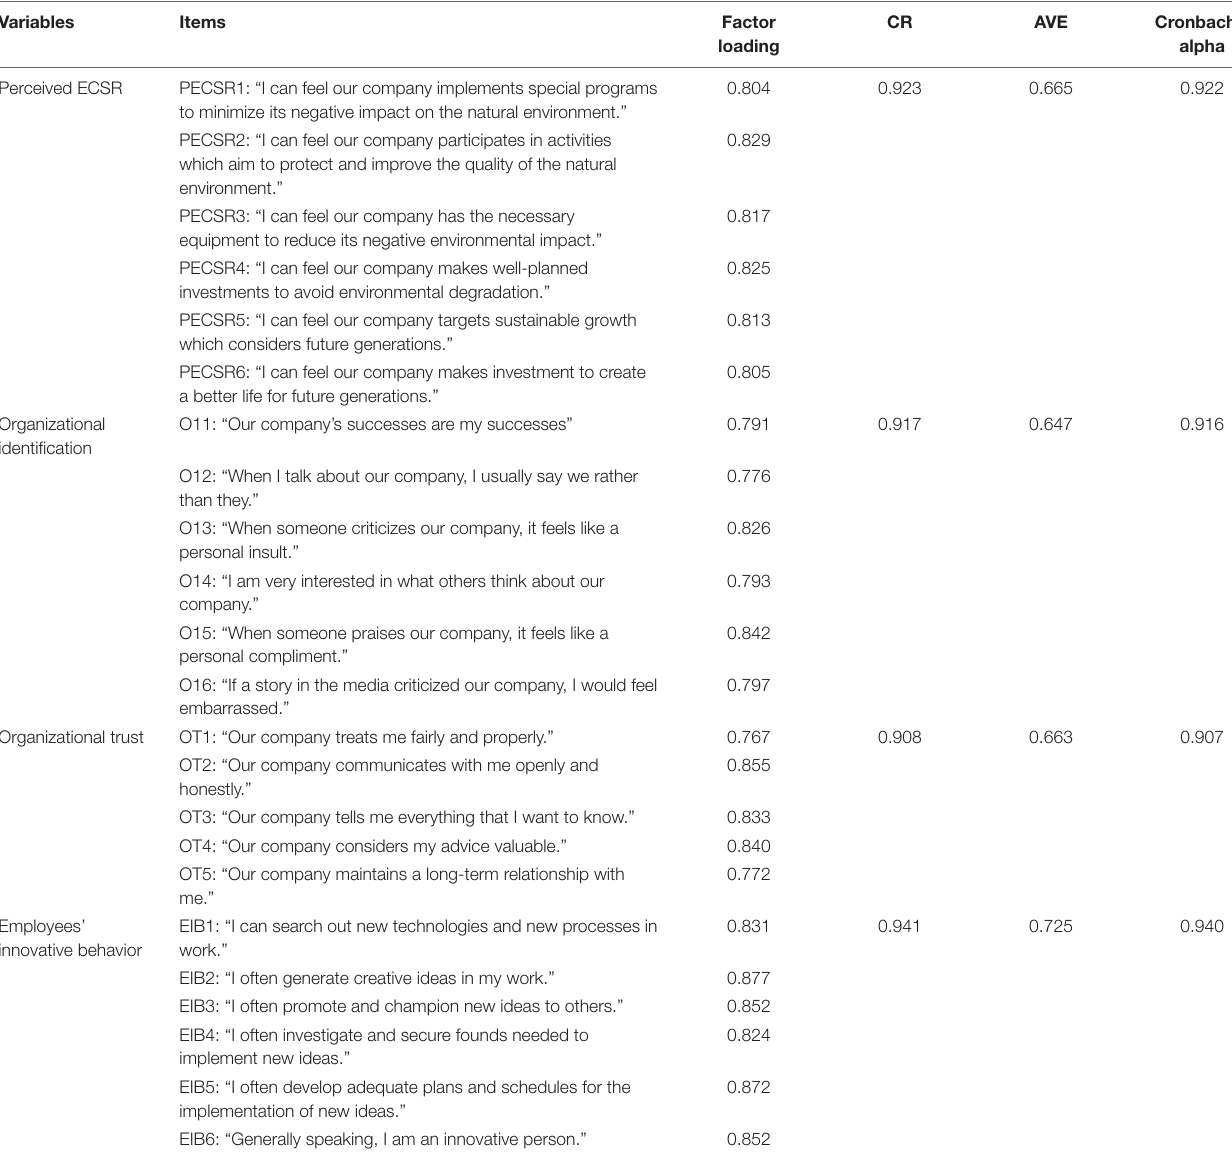
TABLE 1 | Measurement items.